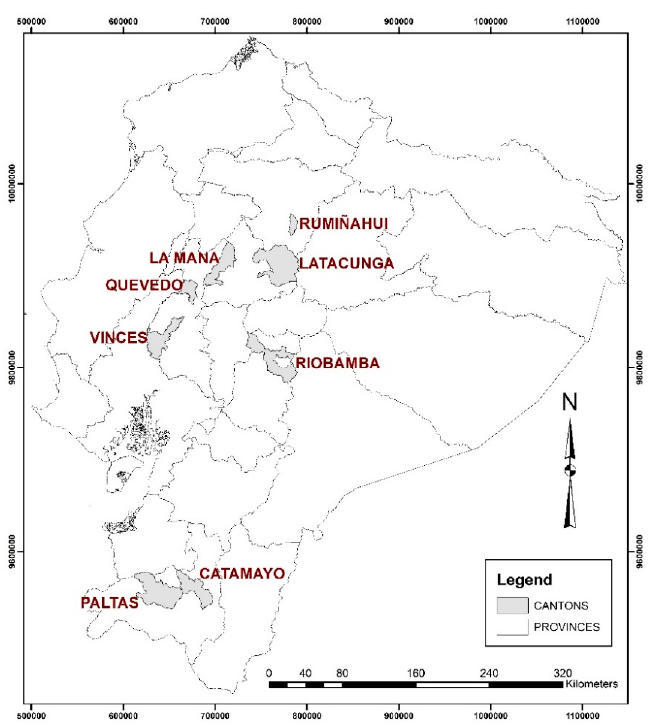
Figure 1. Location of the selected cantons in the respective provinces and planning areas.